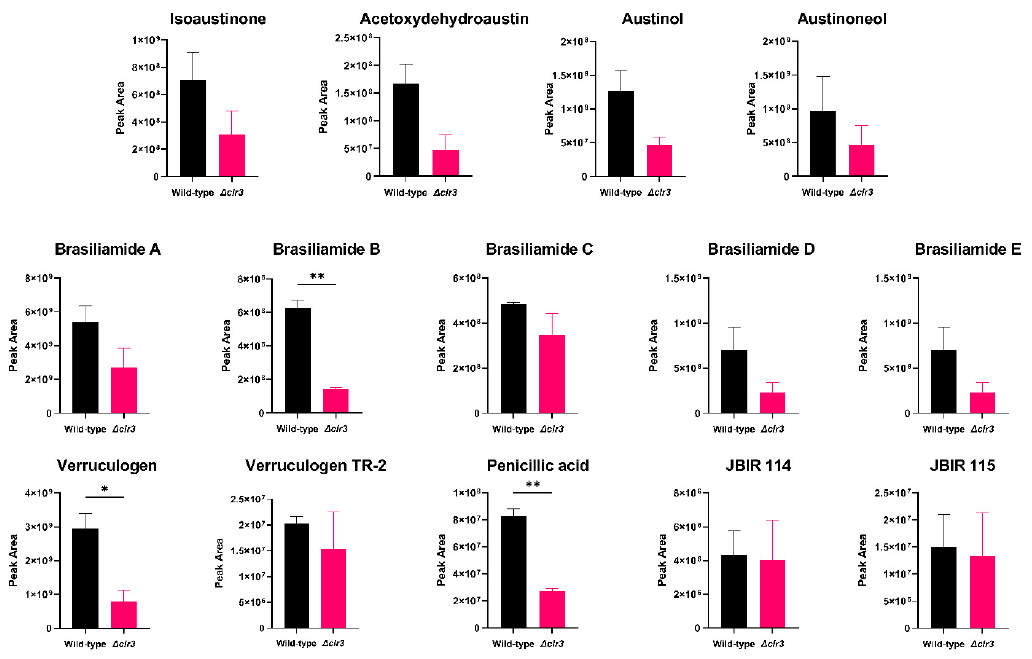
Figure 7. Relative quantification of metabolites in both wild-type and ∆ clr3 strains. The data represent the average value of two replicates. The error bars represent the standard deviation, * p ≤ 0.05, ** p ≤ 0.01 (unpaired t -test, significance level 0.05).